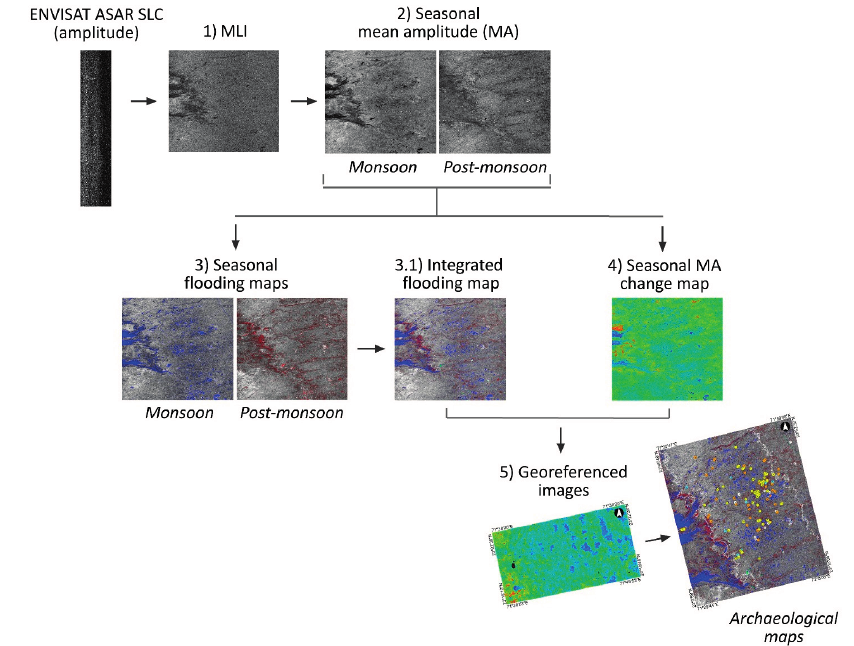
Figure 3. Workflow employed for the ENVISAT ASAR image processing. After co-registration and equalization, a ( 1 ) multi-look (MLI) processing was applied to each amplitude scene. ( 2 ) Images were rotated, transposed, classified upon acquisition time and integrated in two seasonal stacks (MA seasonal images). ( 3 ) A water threshold was applied to obtain (Section 3.1) seasonal flooding maps. Besides. ( 4 ) MA images were divided to obtain the seasonal MA change map. ( 5 ) Final products were georeferenced and integrated into GIS